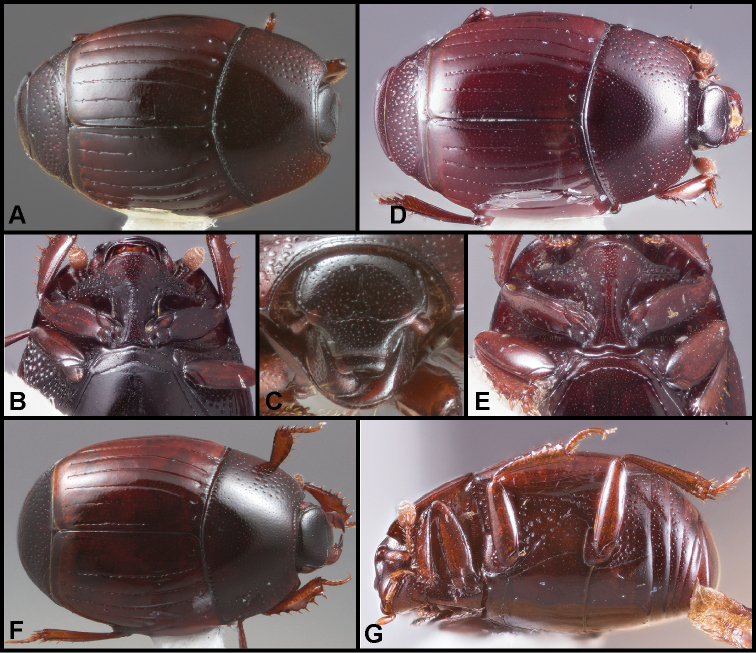
A–CPhelisterbrevistriatus Casey: A Dorsal habitus B Ventral view showing prosternal and meso- and metaventral striae C Frontal view showing median portion of frontal stria D–EPhelistersonorae sp. nov.: D Dorsal habitus E Ventral view showing prosternal and meso- and metaventral striae F–GPhelisterwarneri sp. nov. F Dorsal habitus G Lateral view showing fine meso- and metaventral striae and slender tibiae with reduced lateral spines.